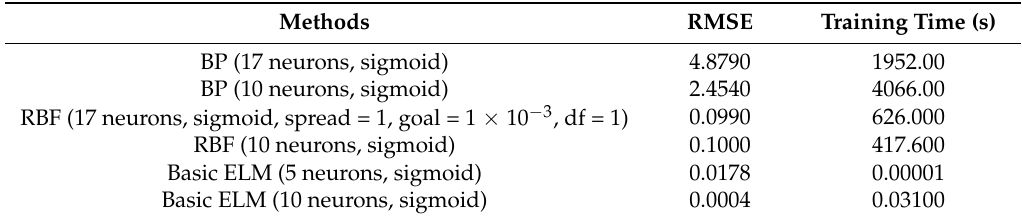
Table 8. Summary of RMSE and training time for backpropagation (BP), radial basis function (RBF) and basic